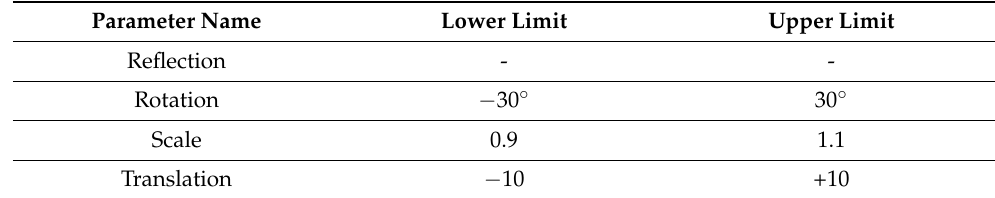
Table 2. Approaches to data augmentation’s lower and upper limitations.